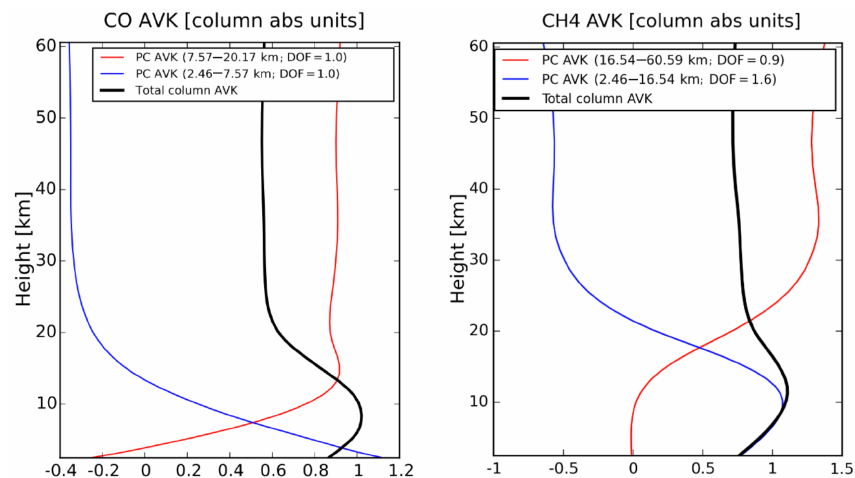
Figure 3. The total column averaging kernel (black) and the partial column averaging kernels of two individual layers (CO: surface–8km and 8–20km; CH 4 : surface–16km and 16–60km) of one typical NDACC retrieval at